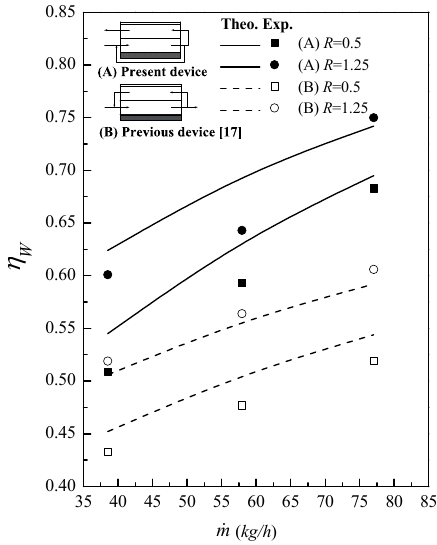
Figure 6. Comparisons of collector efficiency between the present device and the previous work ( I 0 = 830 W/m 2 ). The power consumption increment for the wire mesh packed devices I P ( P S and P W single ‐ pass and double ‐ pass devices, respectively) is defined by the percentage increase in the power consumption compared to that in the downward single ‐ pass device [18,19]: